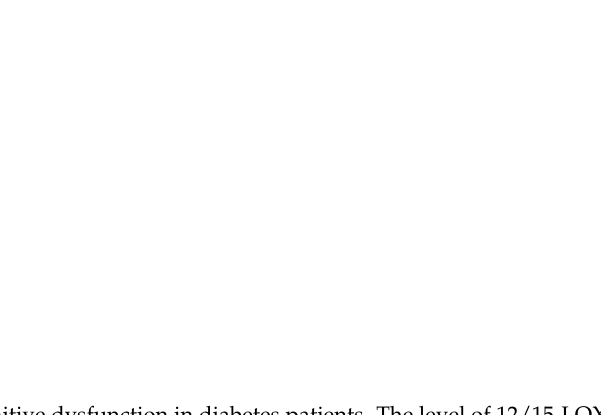
Figure 1. 12/15-LOX is related to cognitive dysfunction in diabetes patients. The level of 12/15-LOX in the plasma of the diabetic patients with cognitive dysfunction.